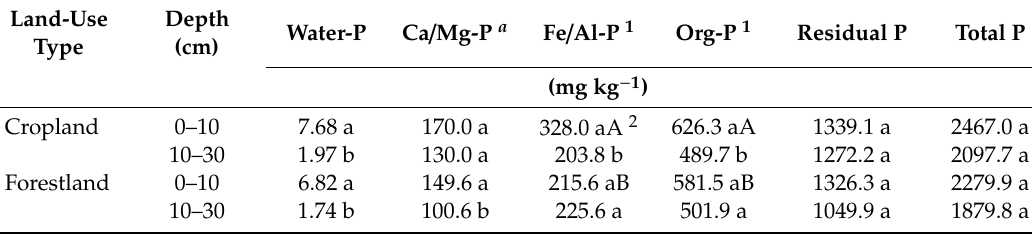
Table 3. Average concentration of P fractions and total P in cropland and forestland in shelterbelt systems ( n =